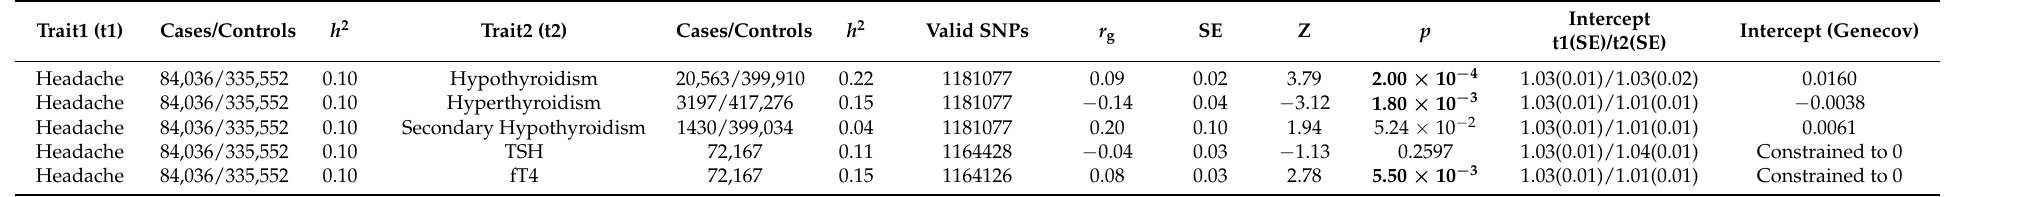
Table 1. Genetic correlation between headache and thyroid traits.